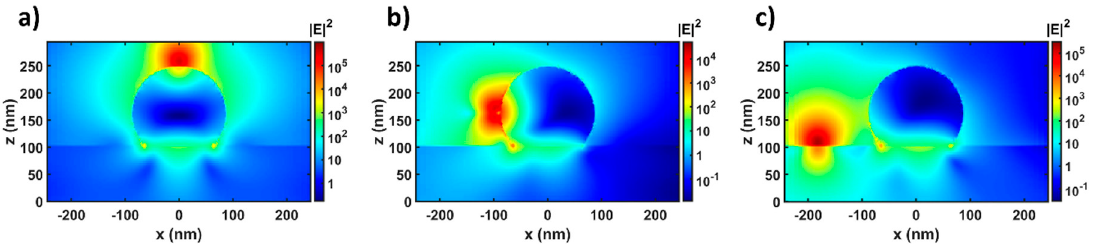
Figure 4. The electrical field profiles at 551 nm on the x–z plane when placing the z-dipoles at Points ( a ) A, ( b ) B, and ( c ) C. All the simulations are run with the aspect factor k = 1.67 and without the q-dipoles added.